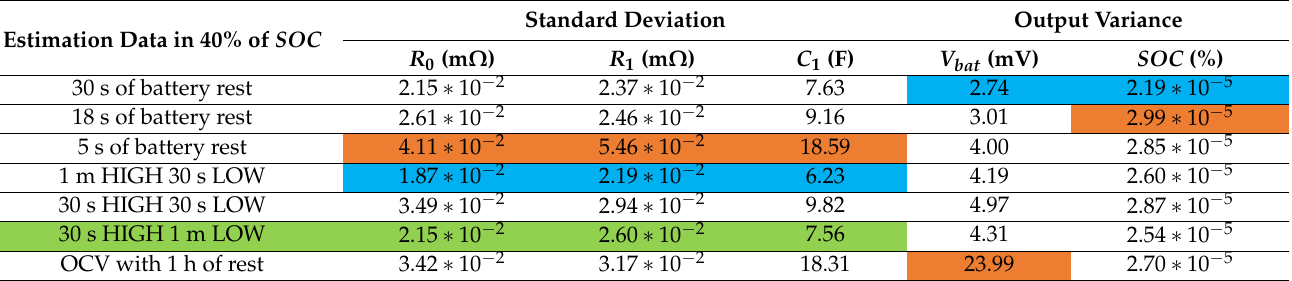
Table 3. Estimated initial states, standard deviation, and output variance of all experiment